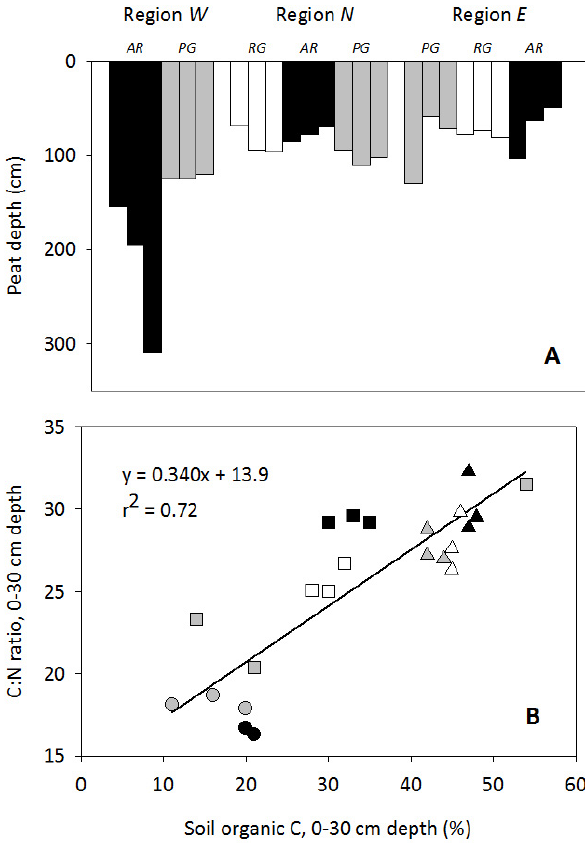
Fig. 1. (A) . Peat depth by experimental block at the eight monitor- ing sites. Key: AR – arable crop; PG – permanent grassland; RG – rotational grass. (B) The scatter plot shows soil C:N ratio as a func- tion of soil organic carbon (%). Key: W-AR, black circles; W-PG, grey circles; N-AR, black triangles; N-RG, white triangles; N-PG, grey triangles; E-AR, black squares; E-RG, white squares; E-PG, grey